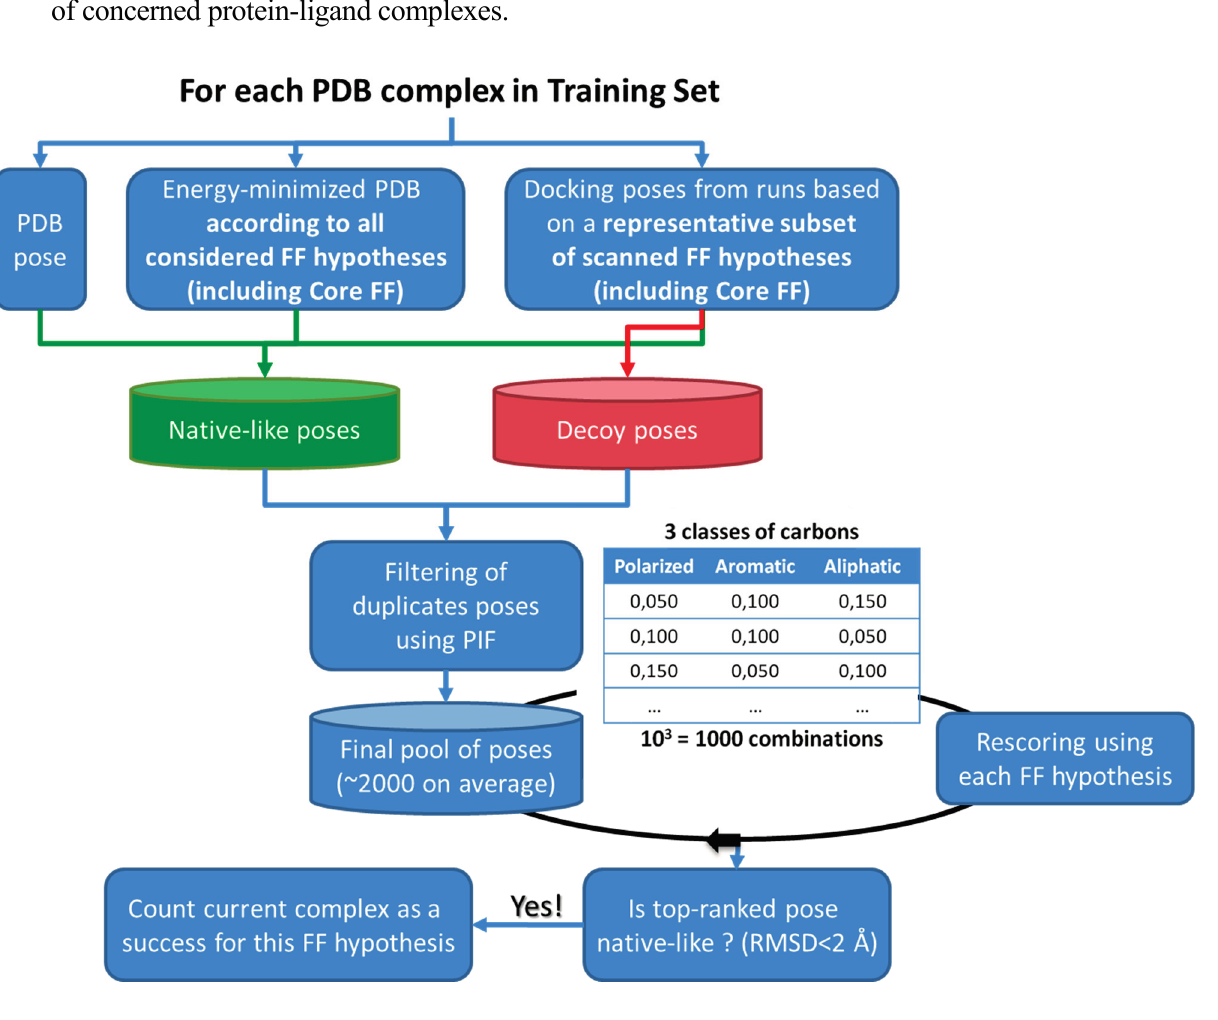
Figure 4. Strategy used in the force field parameter tuning protocol. ‘Decoy poses’ are non-native-like, to be distinguished from the native-like by a proper choice of FF parameters. These three parameters were subjected to a systematic scan. Within the scanned parameter space volume, the representative subset of possible FF configurations includes: Core FF, Preliminary FF setups, setups at the extremes (corners) and at the center of the scanned parameter ‘cube’. This representative subset is used to generate docking poses (one 400-generation run per FF configuration, per